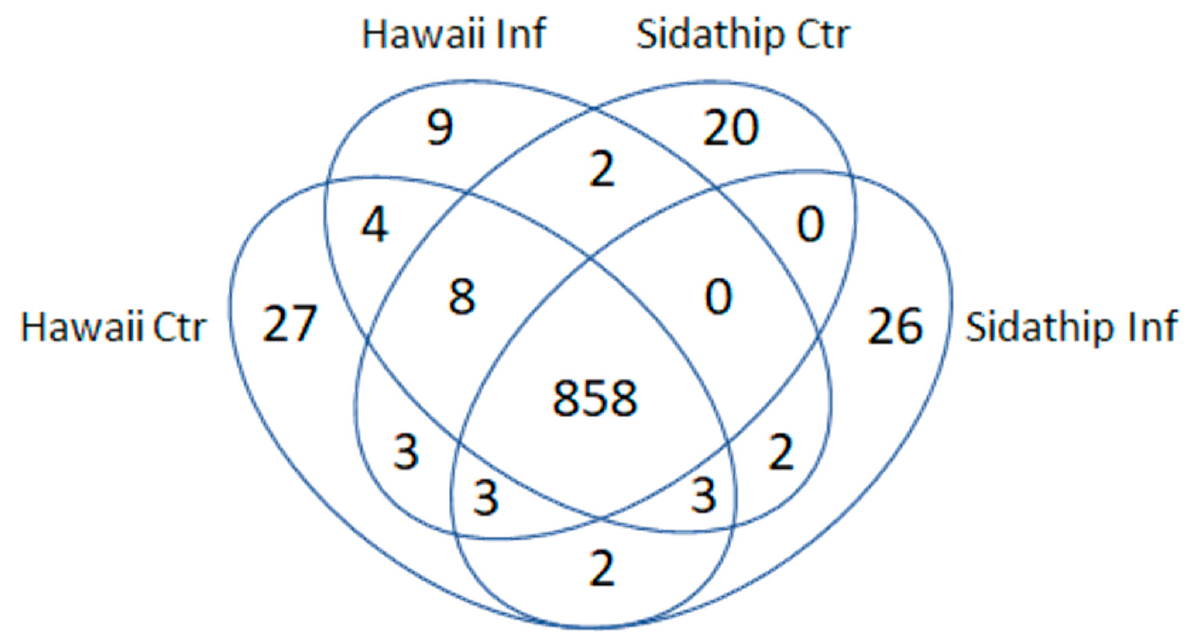
Figure 2. Venn diagram showing overlap pattern of the identified phosphoproteins in the stems of tomato cv. Hawaii7996 inoculated with R. solanacearum (Hawaii Inf), tomato cv. Hawaii7996 mock inoculation with sterilized water (Hawaii Ctr), tomato cv. Sidathip inoculated with R. soalanacearum (Sidathip Inf), and tomato cv. Sidathip inoculated with sterile water (Sidathip Ctr).